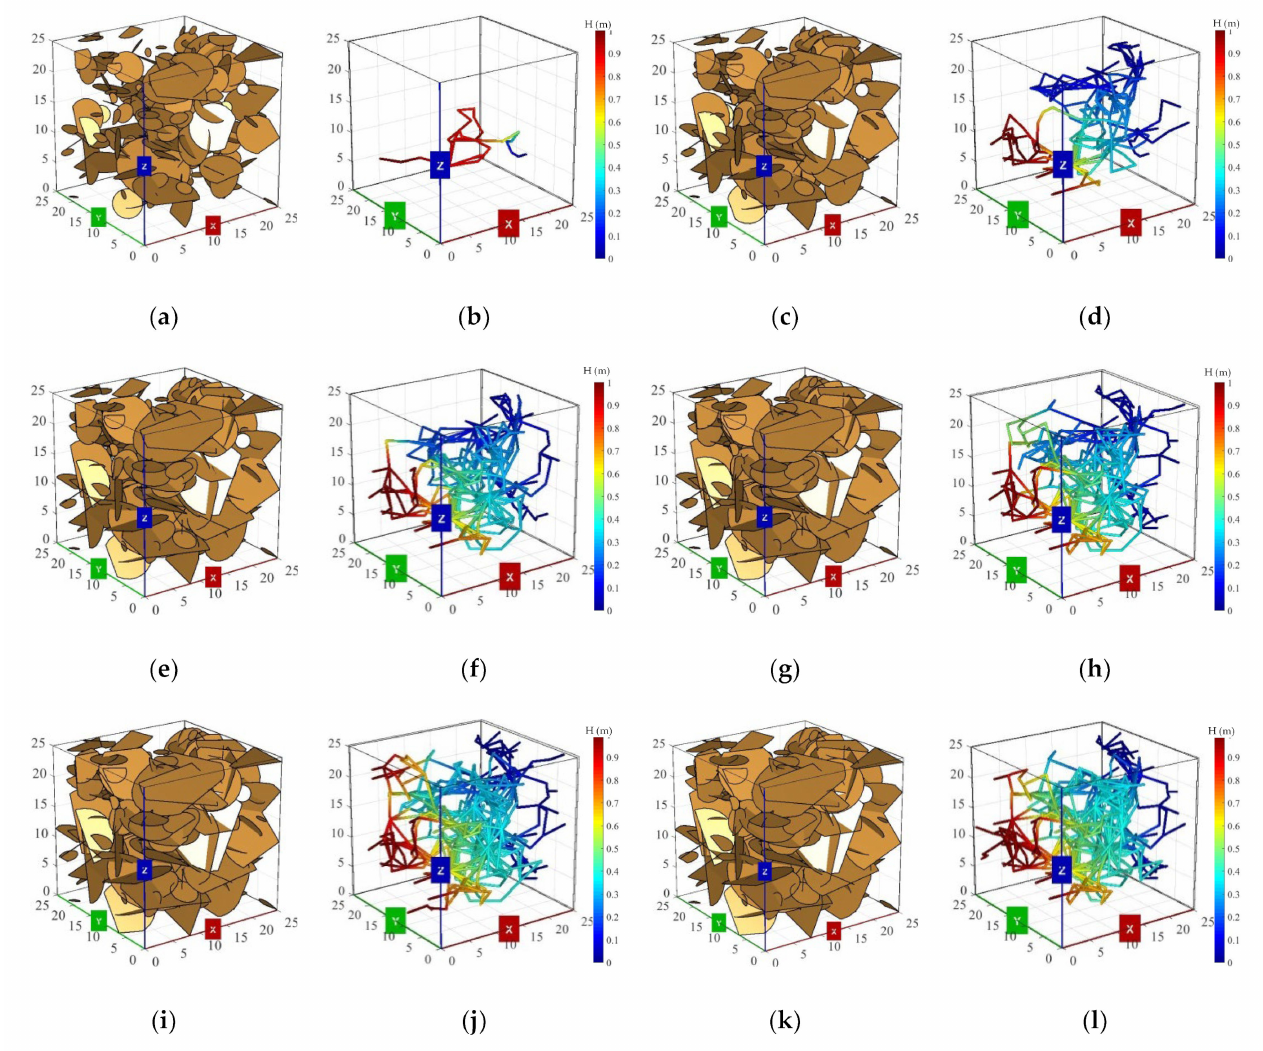
Figure 7. Representative three-dimension DFN models and corresponding EPN models for different u . ( a ) The DFN model when u = 3 m; ( b ) The EPN model when u = 3 m; ( c ) The DFN model when u = 5 m; ( d ) The EPN model when u = 5 m; ( e ) The DFN model when u = 7 m; ( f ) The EPN model when u = 7 m; ( g ) The DFN model when u = 9 m; ( h ) The EPN model when u = 9 m; ( i ) The DFN model when u = 11 m; ( j ) The EPN model when u = 11 m; ( k ) The DFN model when u = 13 m; ( l ) The EPN model when u = 13